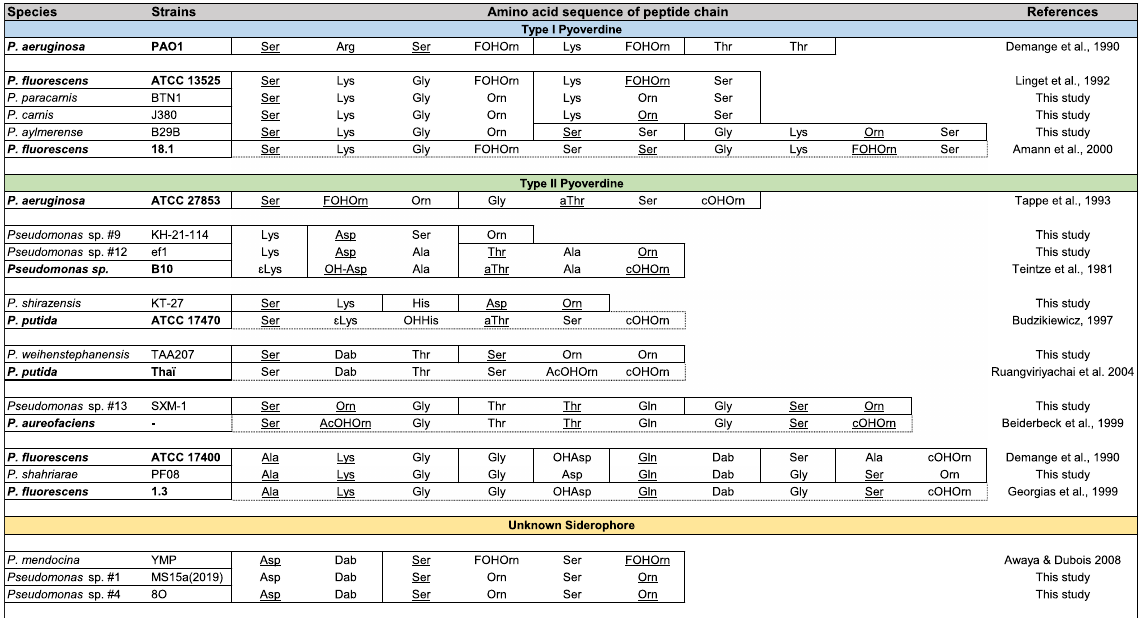
TABLE 3 Siderophores peptide amino-acid sequences